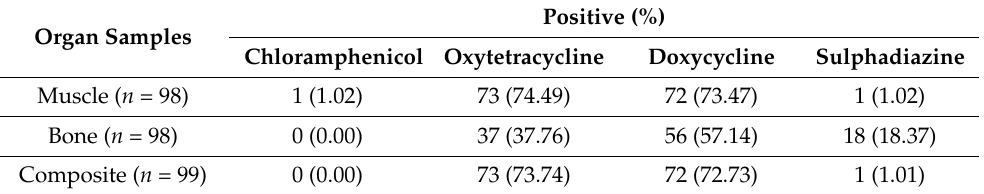
Table 1. Overall percentages of different antimicrobials residue in different parts of the broiler body. Organ